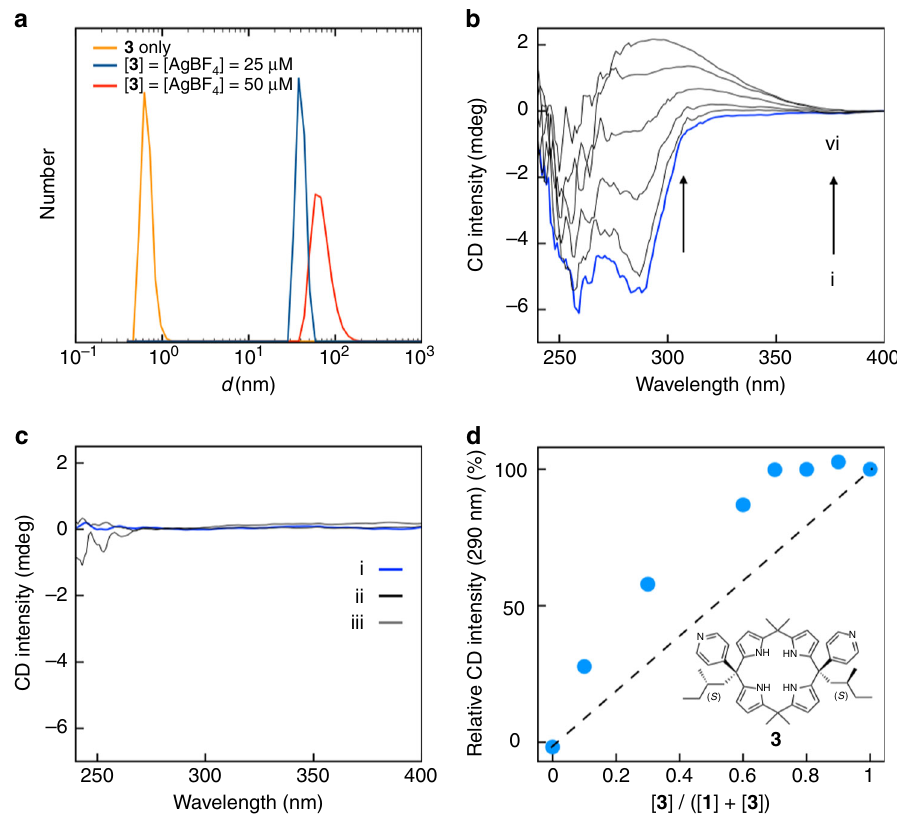
Fig. 3 Operating off the racemic equilibrium state. a Size comparison between 3 and the helix derived from it, as inferred from dynamic light scattering experiments. b CD spectral changes of 3 (2.5 × 10 − 4 mol l − 1 ) upon the addition of AgBF 4 . The concentrations of AgBF 4 are (i – vi) 0.0, 0.5, 1.0, 1.5, 2.0, 2.5 × 10 − 4 mol l − 1 . c CD spectral changes of 1 (2.5 × 10 − 4 mol l − 1 ) seen upon the addition of AgBF 4 . The concentrations of AgBF 4 are (i – iii) 0.0, 1.3, 2.5 × 10 − 4 mol l − 1 . d Plots of the relative CD intensity measured at 290 nm vs mole fraction of 3 . At each datum point, the concentration of AgBF to the total concentration of 1 + 3 . The dotted line indicates the expected CD intensity in the absence of chiral ampli fi cation. All studies were carried out in